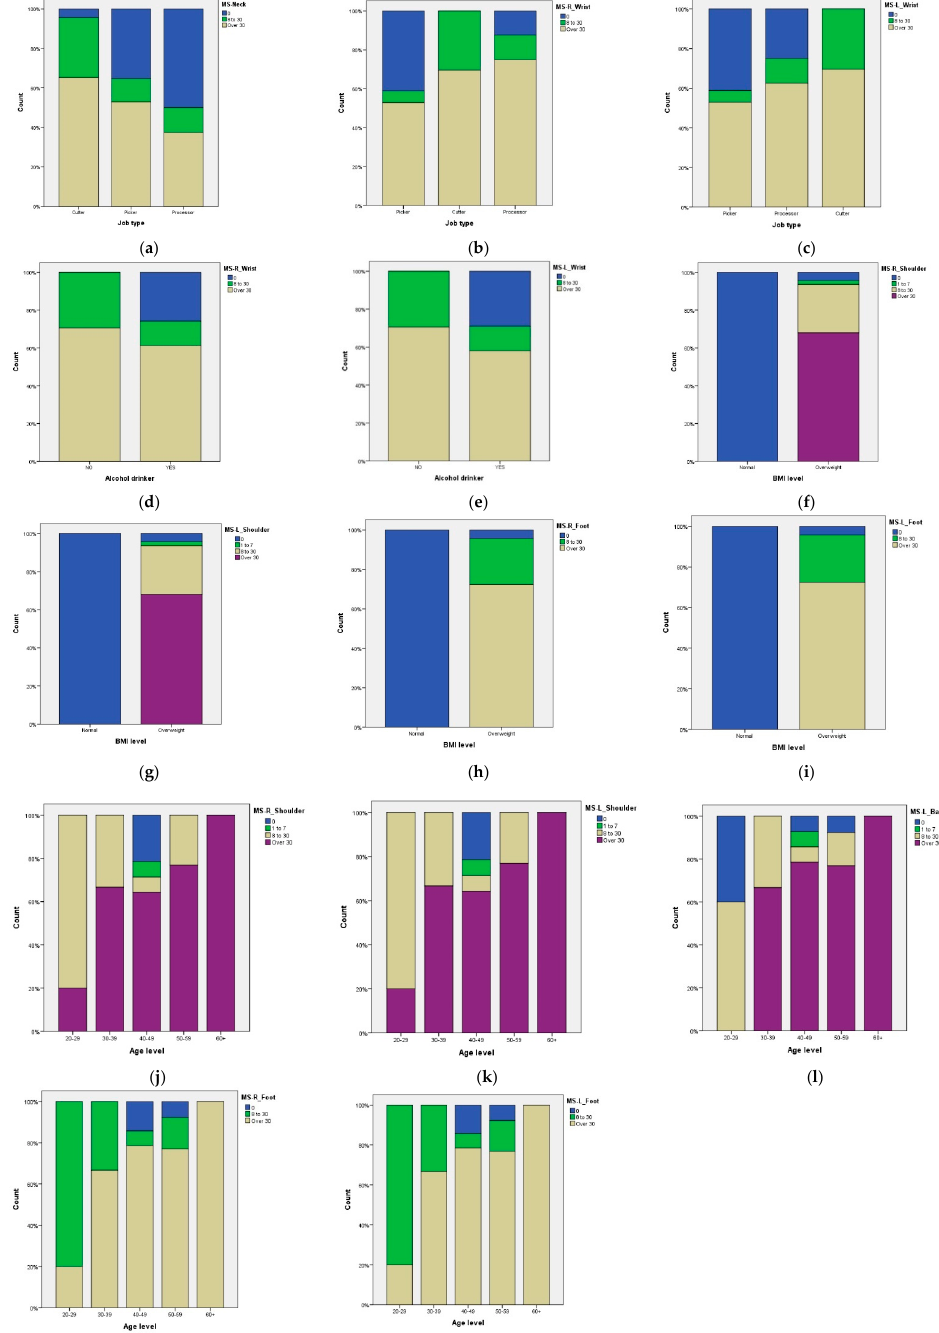
Figure 1. Relation between musculoskeletal symptoms by variables such as job type: ( a ) neck, ( b ) right wrist, ( c ) left wrist; alcohol drinker: ( d ) right wrist, ( e ) left wrist; BMI level: ( f ) right shoulder, ( g ) left shoulder, ( h ) right foot, ( i ) left foot; age level: ( j ) right shoulder, ( k ) left shoulder, ( l ) lower back, ( m ) right foot, ( n ) left foot.